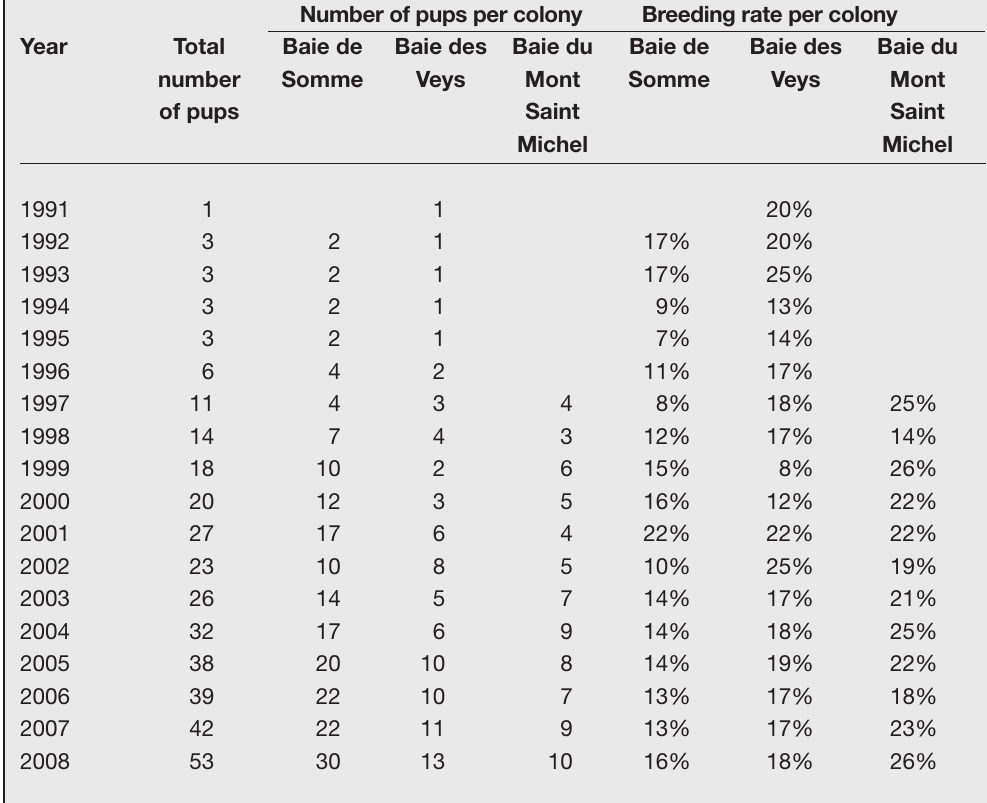
Table 2. Number of pups and breeding rate, for the three harbour seal colonies, expressed as number of pups per total number of